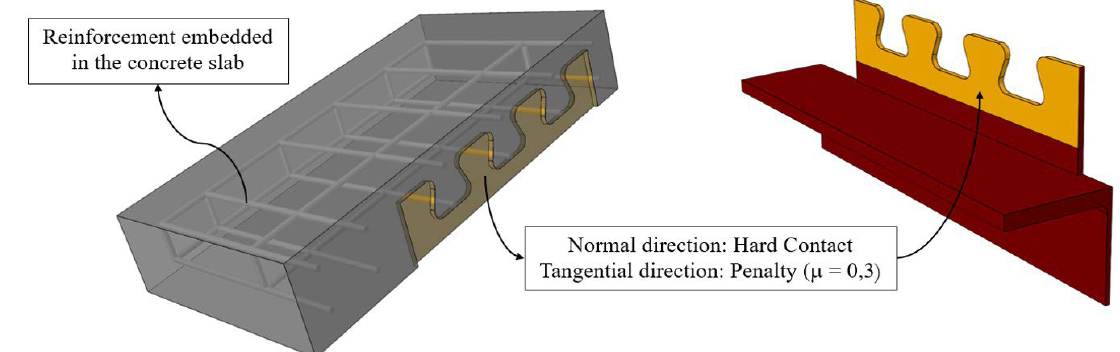
Figure 8. Interactions in the numerical model (Group